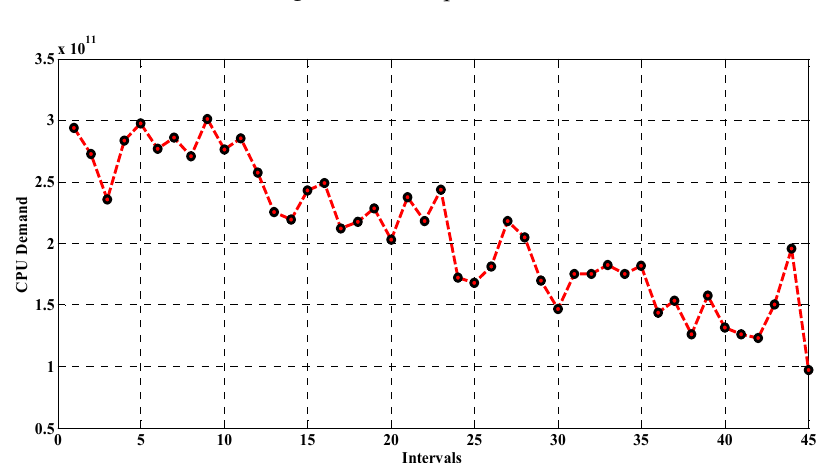
Figure 4. Processor demand at different intervals